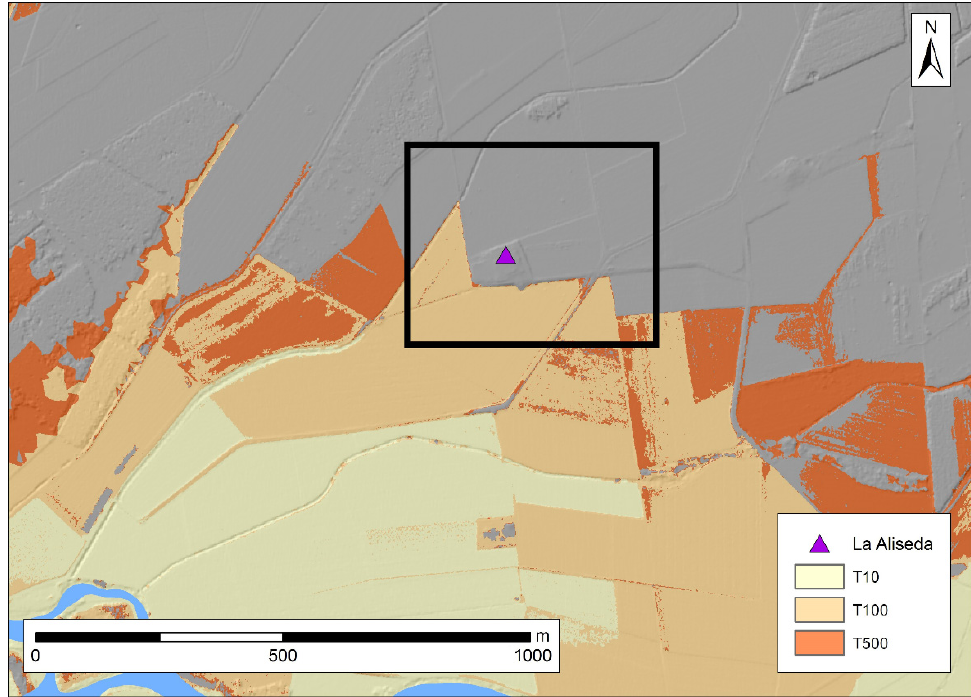
Figure 9. APSFR analysis corresponding to the area where the La Aliseda tumulus is located (Don Benito, Badajoz, Spain). It shows how both the T100 event and the T500 event stop just on the west and south faces of the mound, creating a straight distortion that marks the boundary of the plot. Therefore, the plot on which the settlement is located is at a higher elevation so that the flood event has its limits at the contour of the plot.